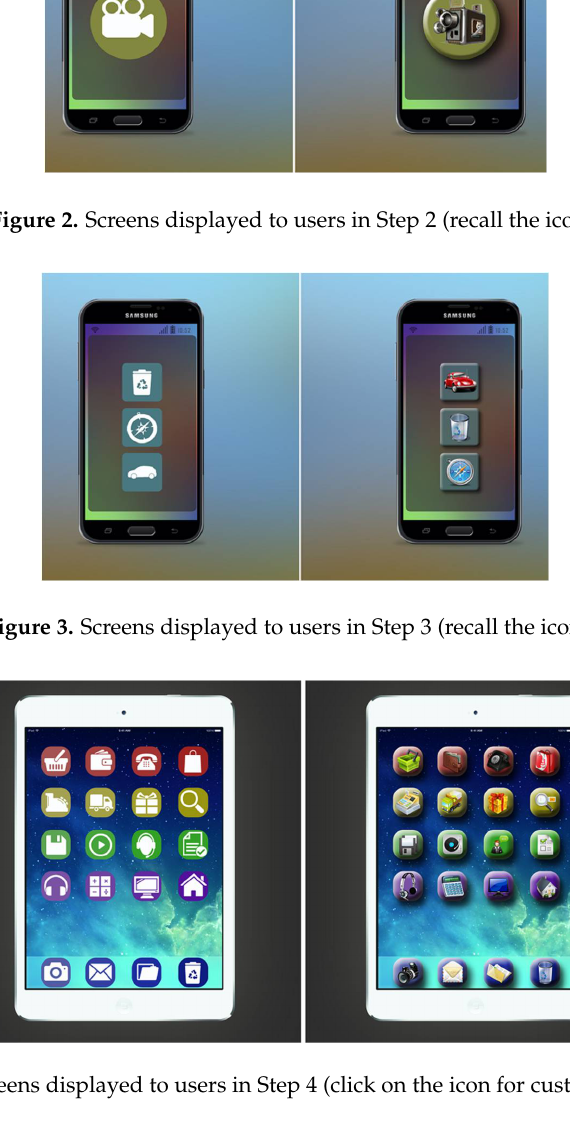
Figure 5. Icon sets displayed to users in Step 5 (recall as many as possible).